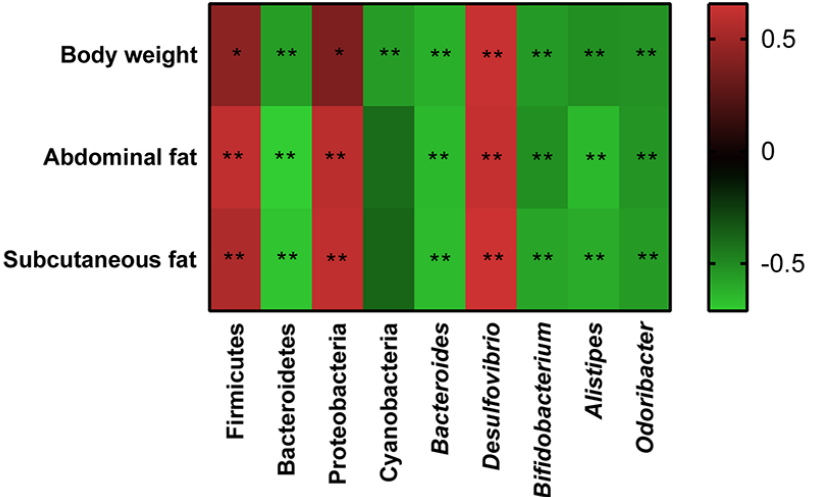
Figure 7. Heatmap of Spearman’s correlation between the gut microbiota and obesity-related indexes. The colors range from blue (negative correlation) to red (positive correlation). Significant correlations are marked by * p < 0.05 and ** p < 0.01.